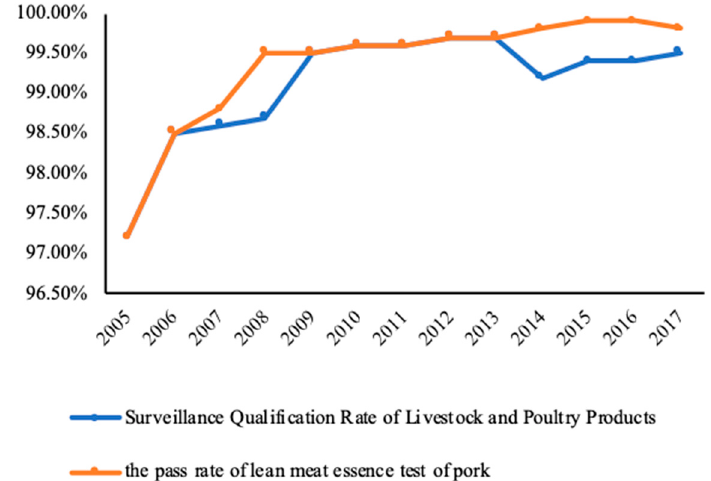
Figure 1. Qualification rate of the lean meat essence contaminant monitoring of livestock and poultry products in China, from 2005–2017.